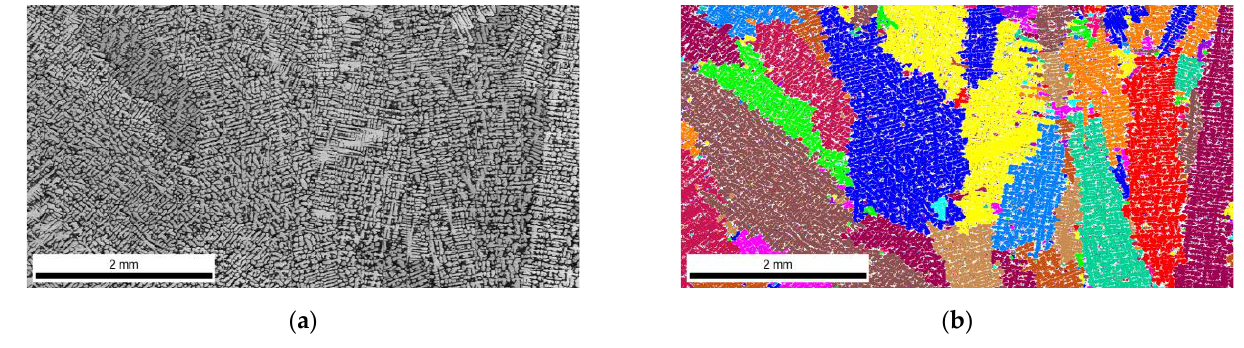
Figure 7. Structure of chromium cast iron in a 30 mm thick plate. ( a ) light microscope; ( b ) EBSD.